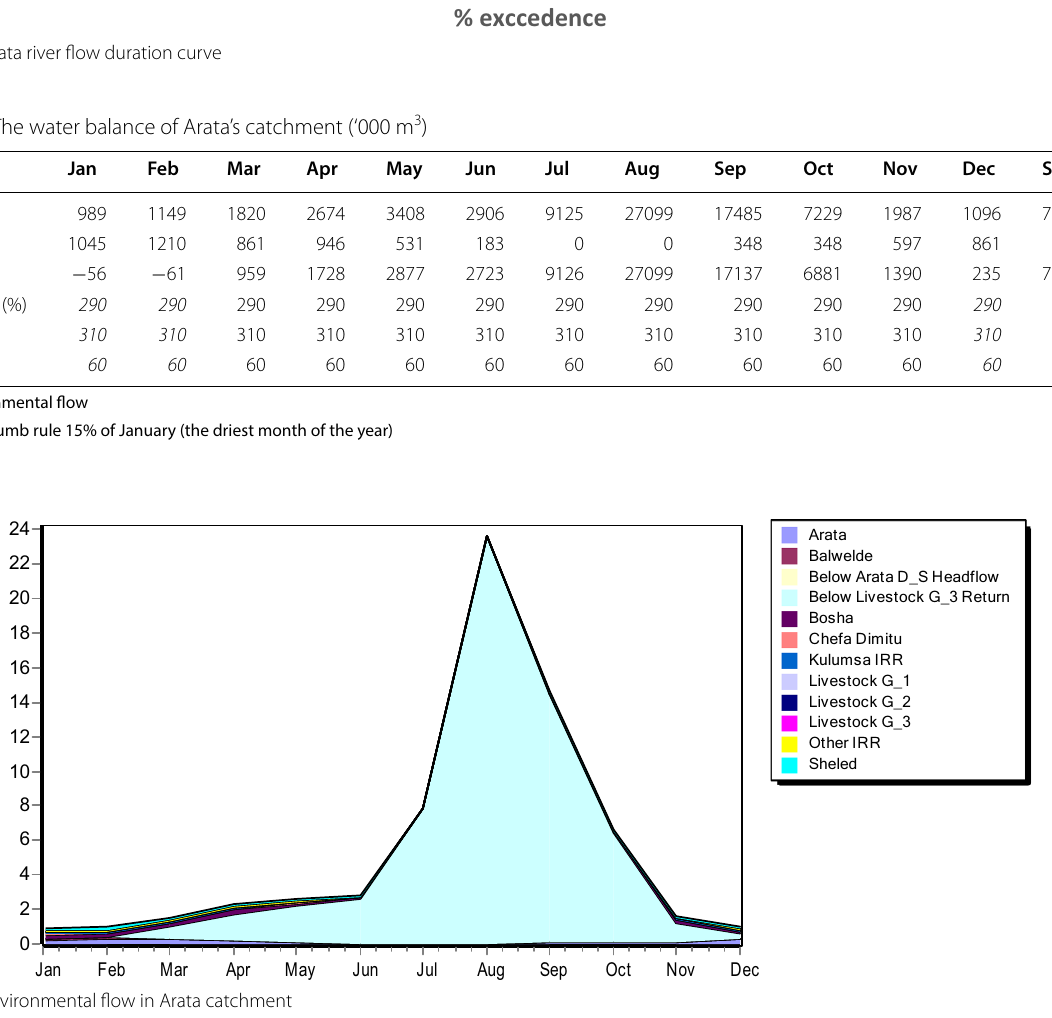
flow in January and February. Smakhtin et al.(2004)